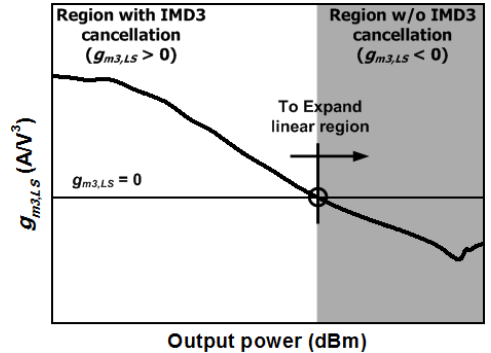
Figure 4. Conceptual diagram of g m 3 ,LS of driver stage.